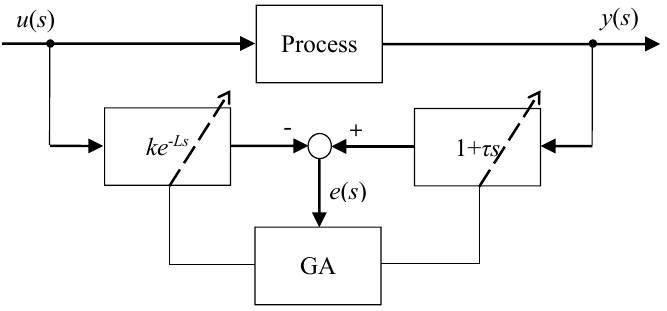
Figure 3. Block diagram for parameter estimation.